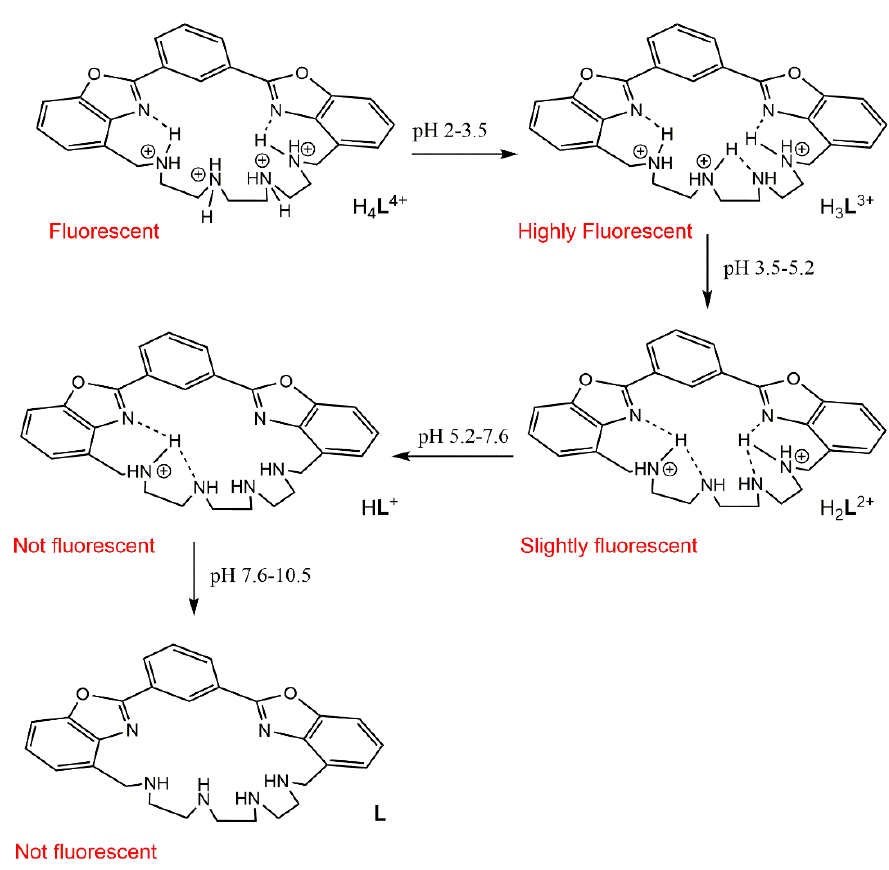
Figure 6. Proposed disposition of H + in the protonated forms of the ligand.